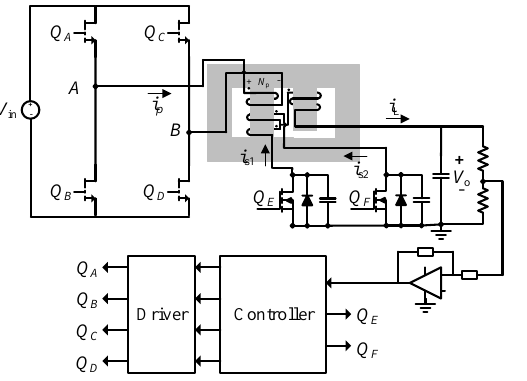
Figure 3. Application of an integrated magnetic component in a phase-shifted full-bridge con- verter.